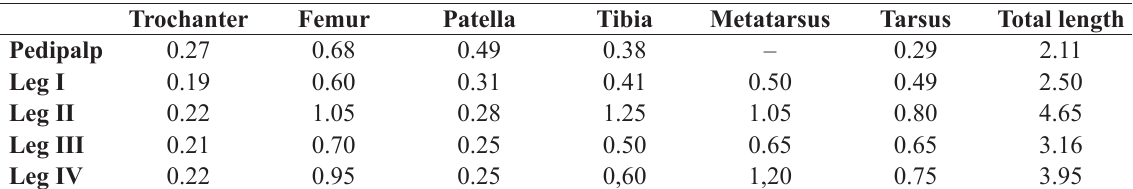
Table 7. Length of appendage-segments in millimeters in N. pluridentatum (Hadži, 1973) stat. nov. from Mt. Paljenik, Bosnia and Herzegovina: ♂ holotype, ♀